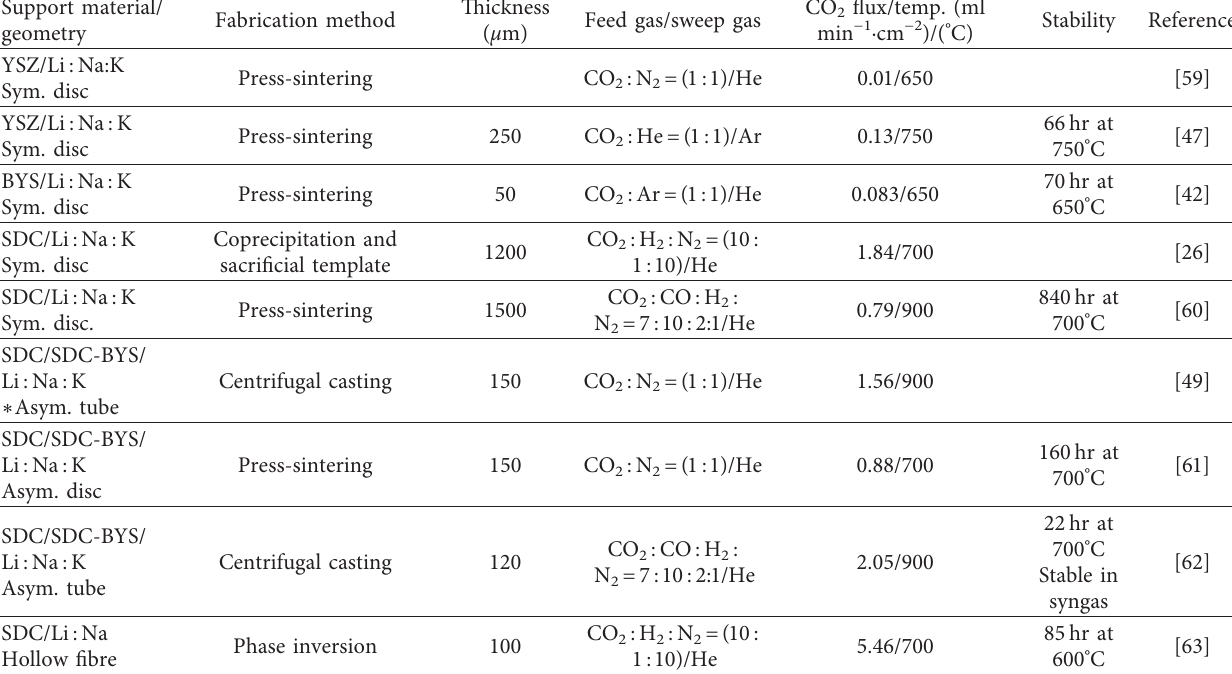
Table 3: Comparison of CO 2 fluxes and stabilities for different types of MOCC